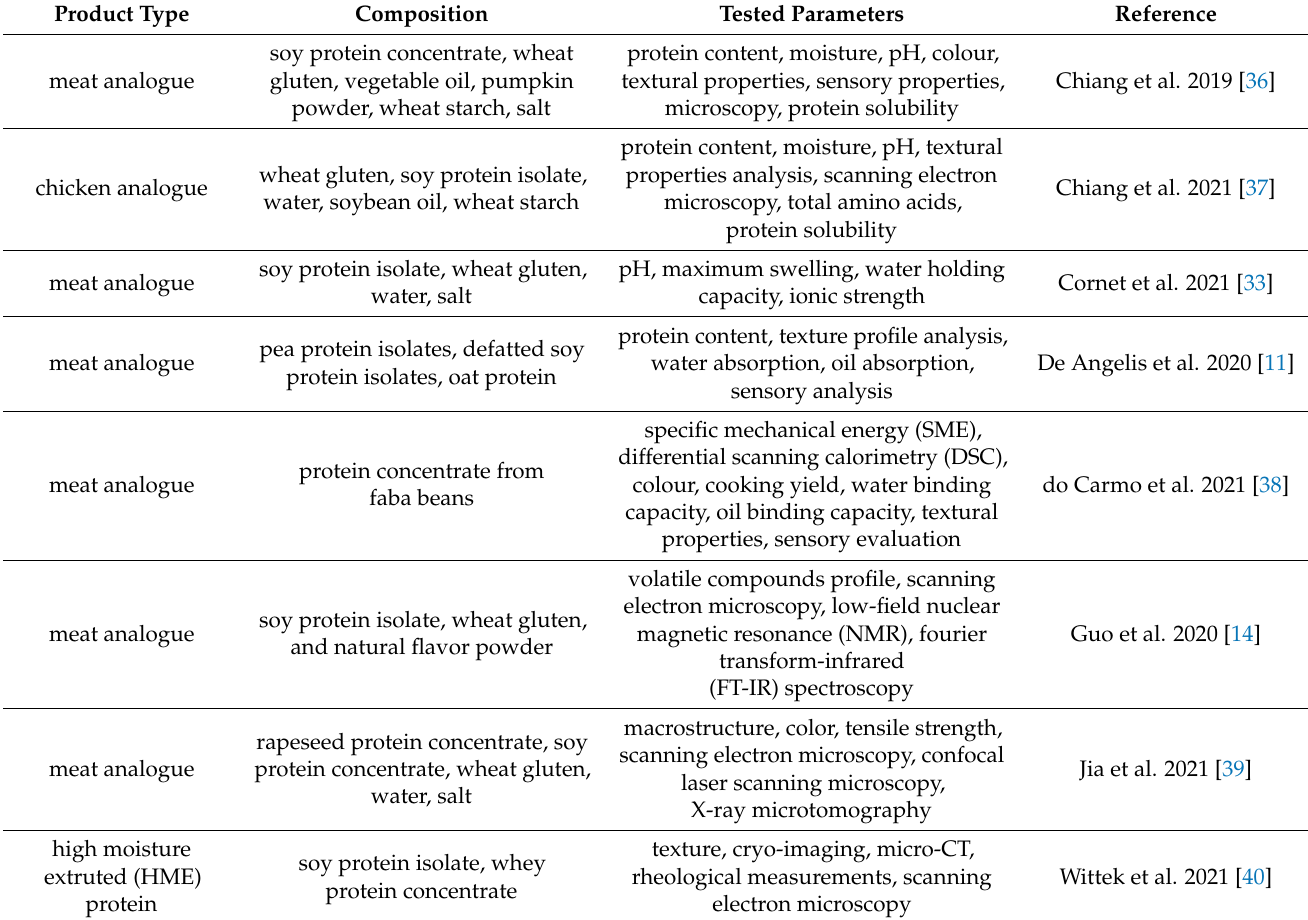
Table 1. Composition of meat analogues in scientific